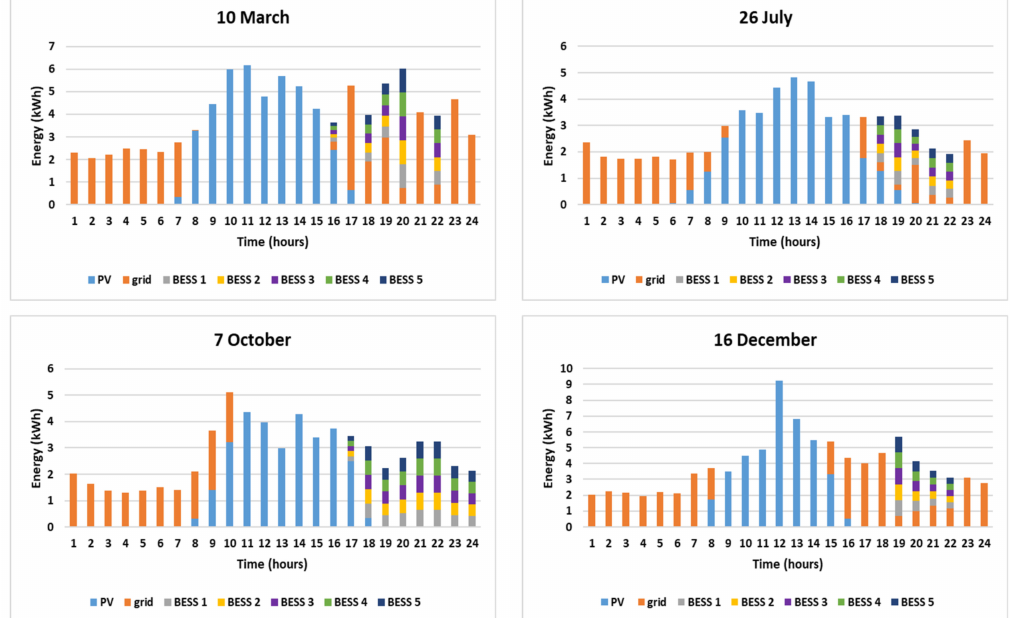
Figure 8. Energy mix of each simulated day for scenario